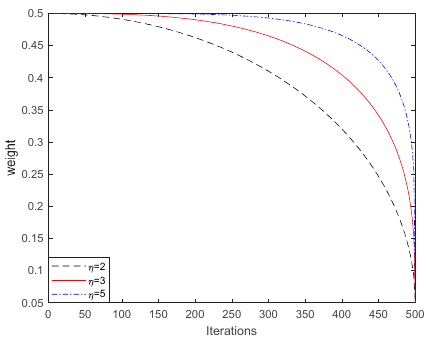
Figure 2. Comparison of different η .